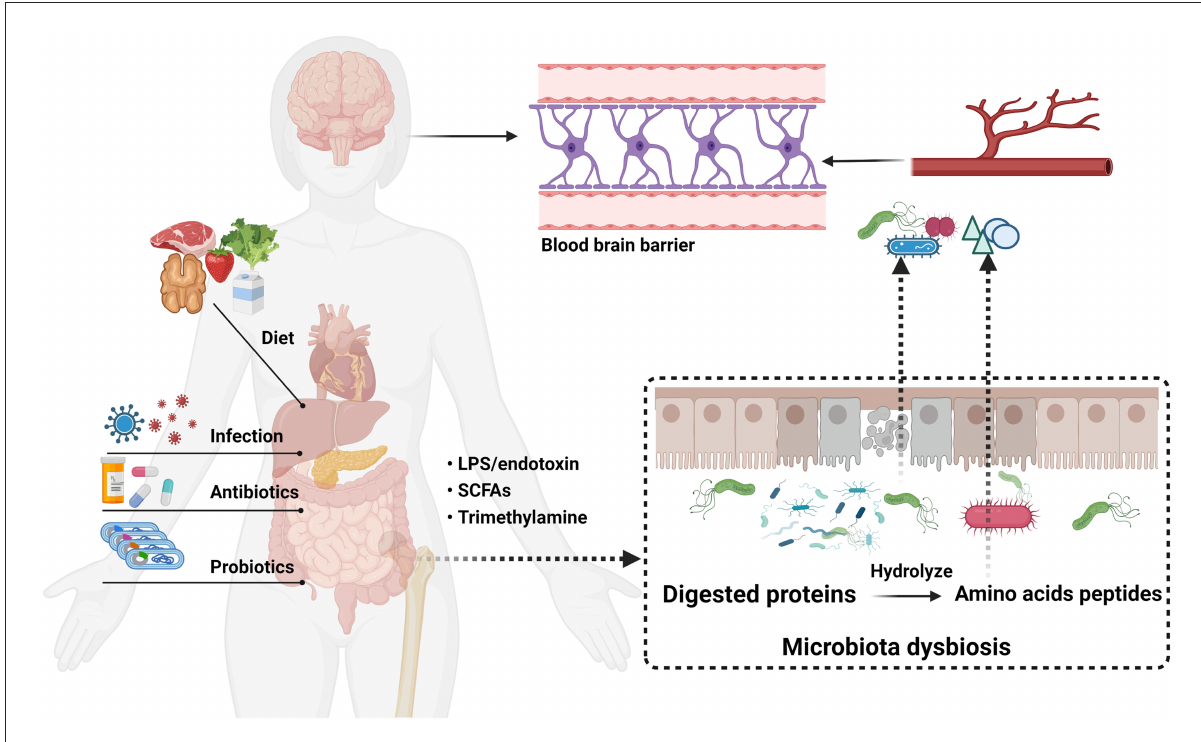
FIGURE2 Microbiota-gut-brain axis communication pathway linking gut microbial dysbiosis with brain function in